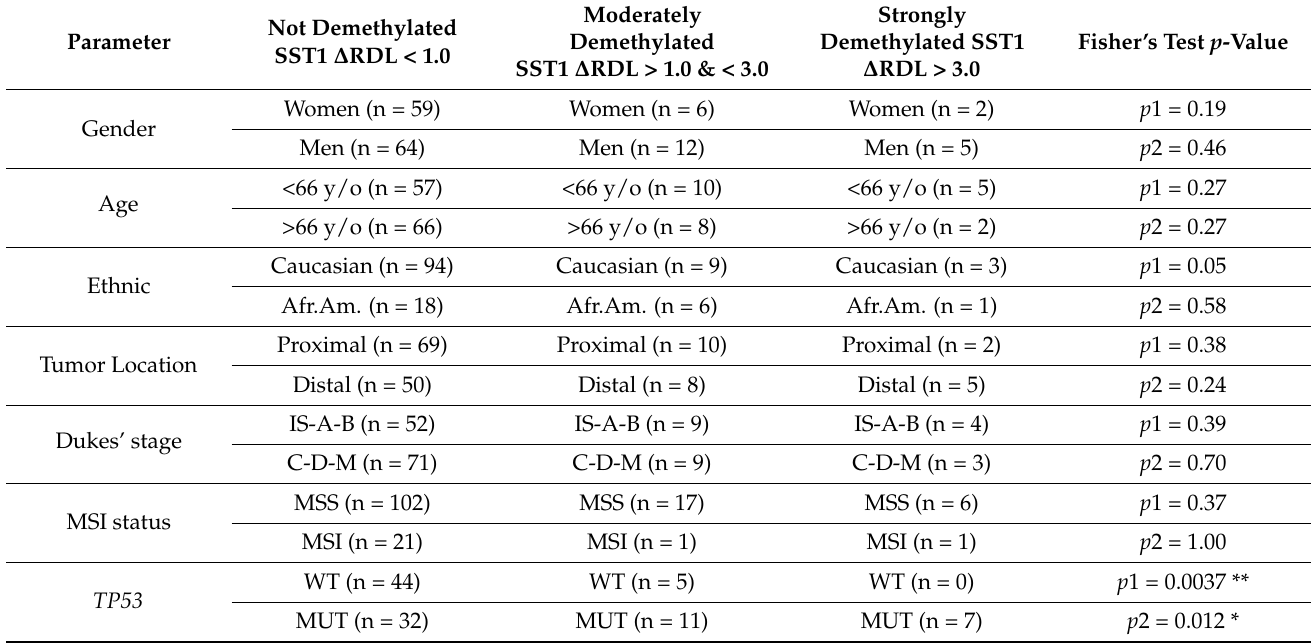
Table 1. Association of SST1 demethylation with CRC genotype and